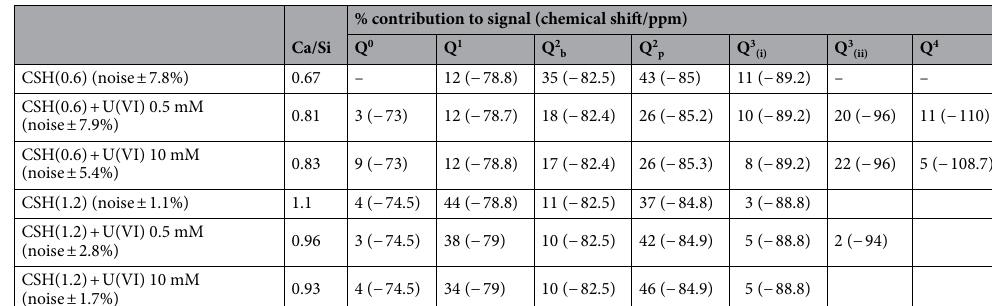
Table 3. Percentage of Si Q n species in CSH(0.6) and U(VI)-contacted CSH(0.6) systems and CSH(1.2) and U(VI)-contacted CSH(1.2) systems, with the chemical shift (δ obs , ppm) given in brackets below each percentage value. The Ca/Si ratio was determined from 29 Si NMR data, using Eq. (1).